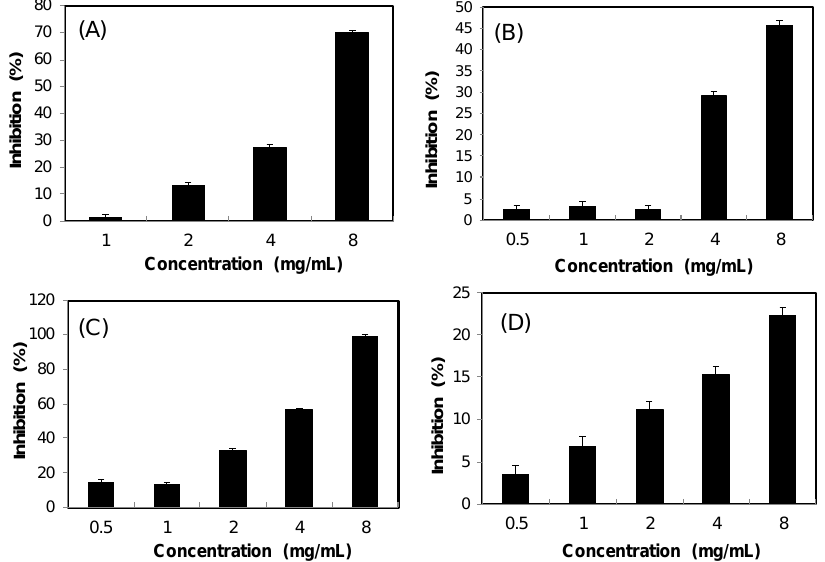
Figure 6. Inhibitory activities of S. orientalis extracts on pancreatic lipase. ( A ) SE; ( B ) SE-Hex; ( C ) SE-EA; and ( D ) SE-MeOH.